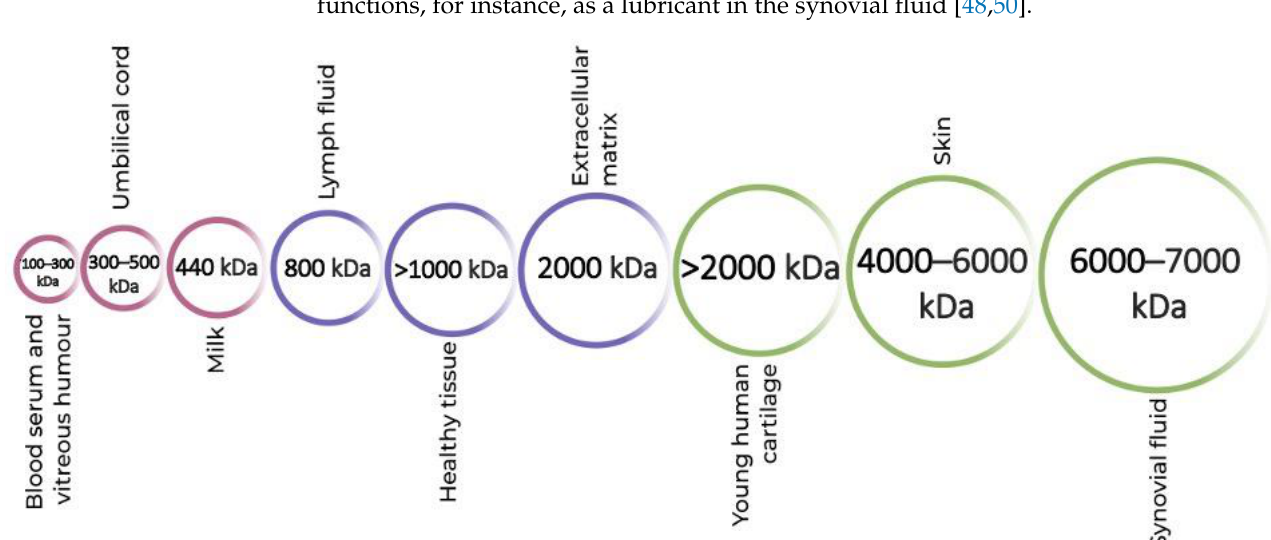
Figure 1. Molecular weights of hyaluronic acid in different parts of the human